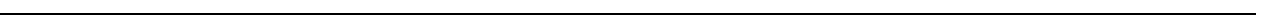
Fig. 3 Identi fi cation of NAMPT as the cellular target of KPT-9274 using a CRISPR-Cas9 tiling library. a Experimental work fl ow for the CRISPR-Cas9-based target identi fi cation screen for KPT-9274. HAP1 or K-562 SpCas9 + cells were transduced with the investigational target gene library spanning 75